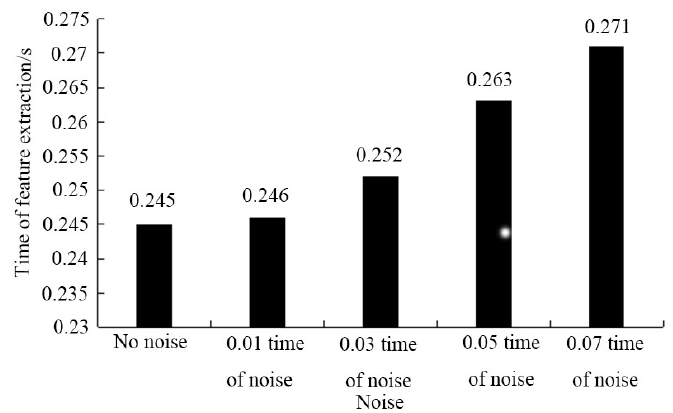
Figure 3: Feature extraction time under different noise conditions